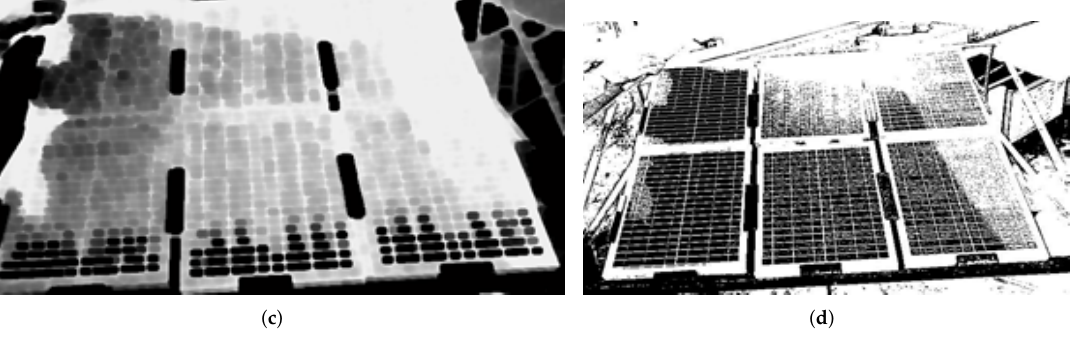
Figure 2. Image processing techniques in MALTAB libraries. ( a ) Canny Edge detection. ( b ) Mor- phed image. ( c ) Dilated image. ( d ) Black&White image.